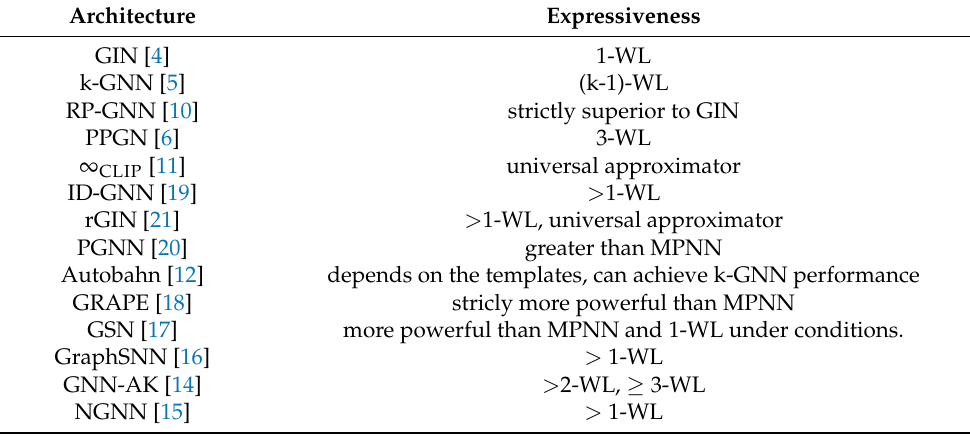
Table 2. Expressiveness of GNNs. Expressiveness is given with respect to how the authors proved the results. GIN corresponds to the most powerful standard MPNN.